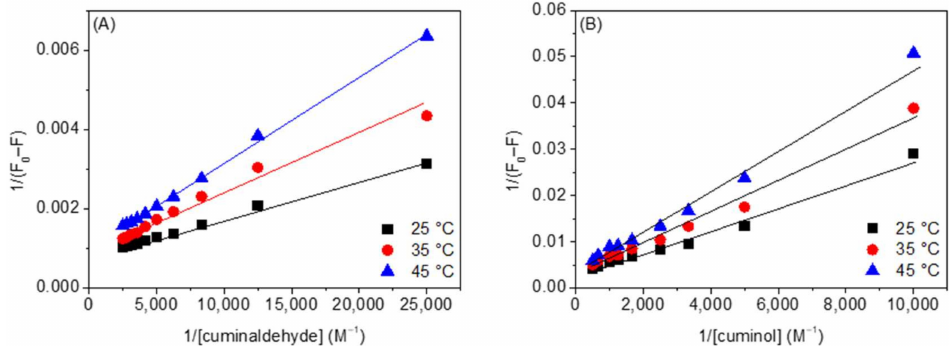
Figure 6. Lineweaver-Burk plots of ( A ) HSA-cuminaldehyde and ( B ) HSA-cuminol systems at various temperatures.